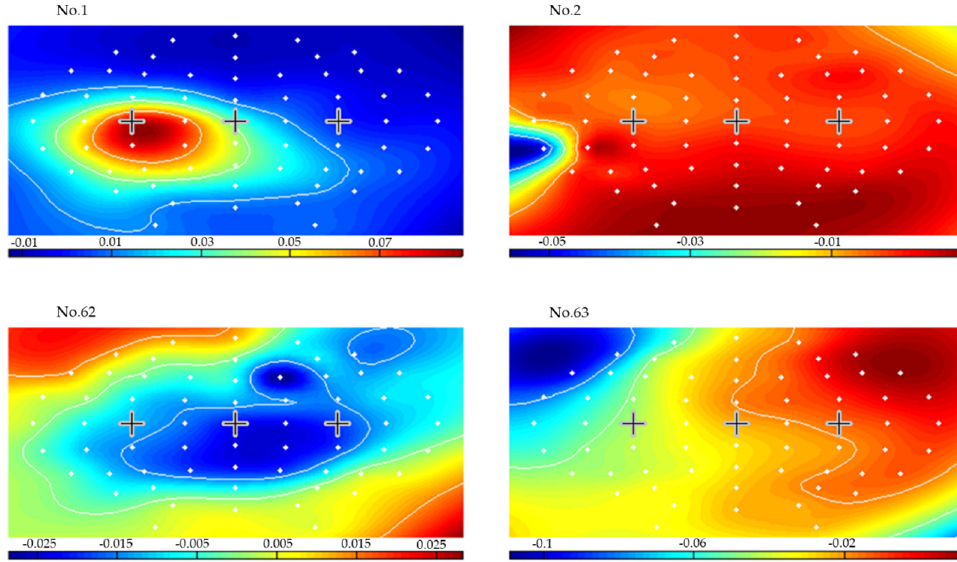
Figure 10. Maps of the most significant common spatial patterns for a 3 s window length from second 3.5 to second 6.5 for right hand versus all (subject 1).